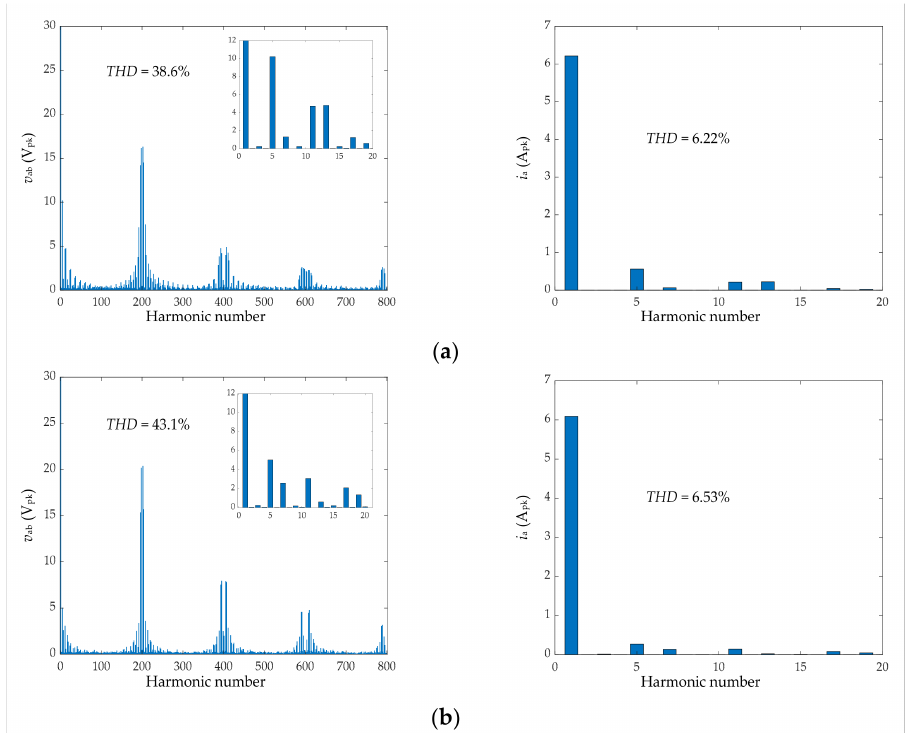
Figure 11. Line-to-line voltage and phase current harmonic distortion under m = 1.075 and hbc = 1. ( a ) Algorithm implemented with Algorithms 1 and 2; ( b ) algorithm implemented with Algorithms 2 and